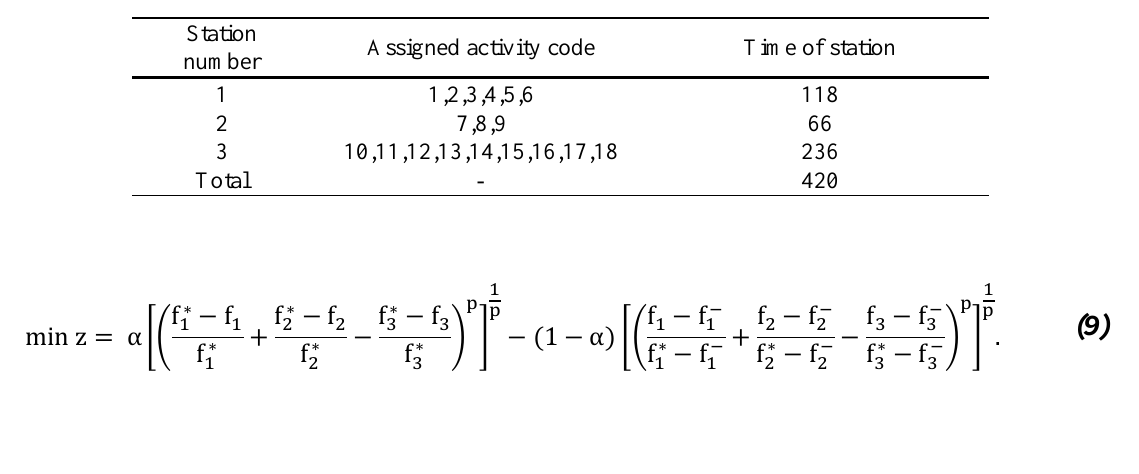
Table 5. Three-objective model information for global criteria method.